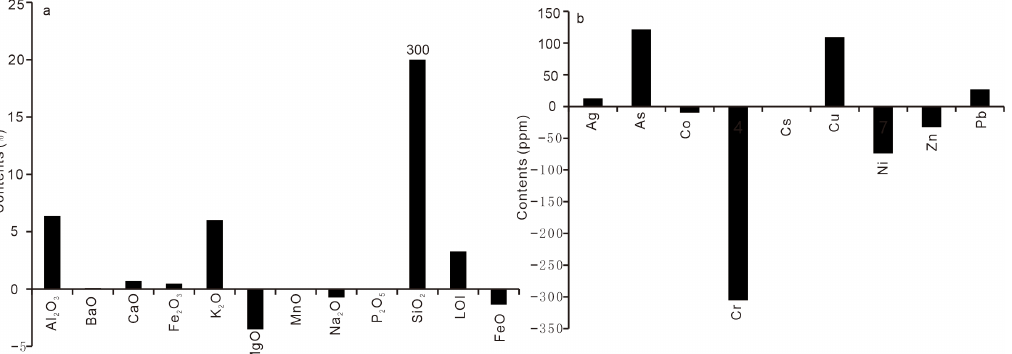
Figure 6. Gain–loss diagram for elements in Silicic alteration processes in the Wulong gold deposit (data listed in Table 1). ( a ). Gain–loss diagram for major elements in Silicic alteration processes; ( b ). Gain–loss diagram for trace elements in Silicic alteration processes.